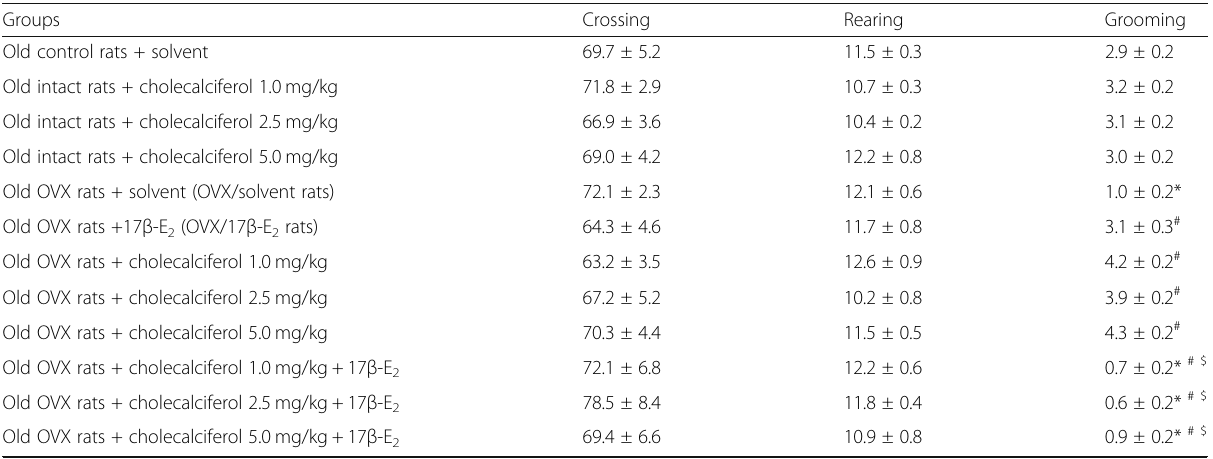
Table 1 Effects of Vitamin D 3 administration on behavior of the old ovariectomized (OVX) rats following long-term estrogen deficiency in the open field test for 5 min Groups